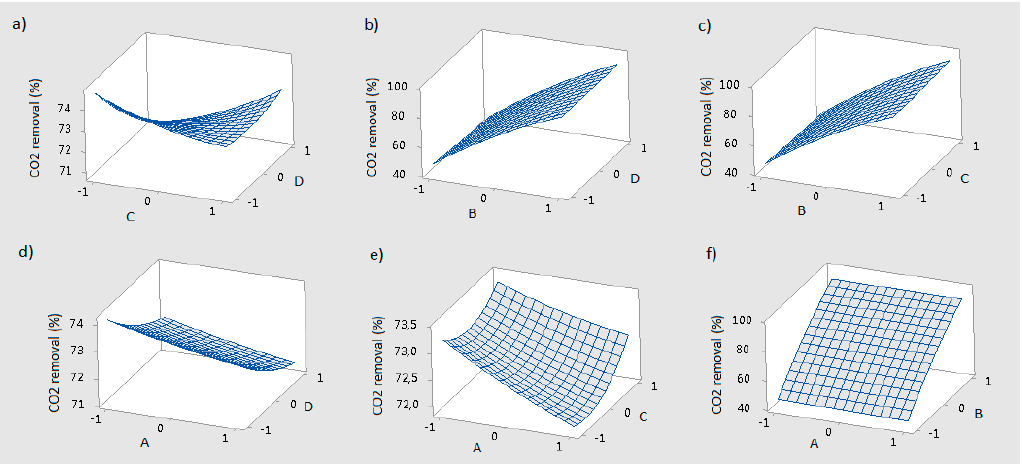
Figure 7. Response surface plots for percentage of carbon dioxide removal (%) as a function of: ( a ) factor C and D ; ( b ) factor B and D ; ( c ) factor C and B ; ( d ) factor A and D ; ( e ) factor A and C ; ( f ) factor A and B . (Hold values: A = B = C = D = 0) (factor A = flue gas inlet temperature, factor B = column pressure, factor C = carbon dioxide composition in flue gas, factor D = height of the absorber).